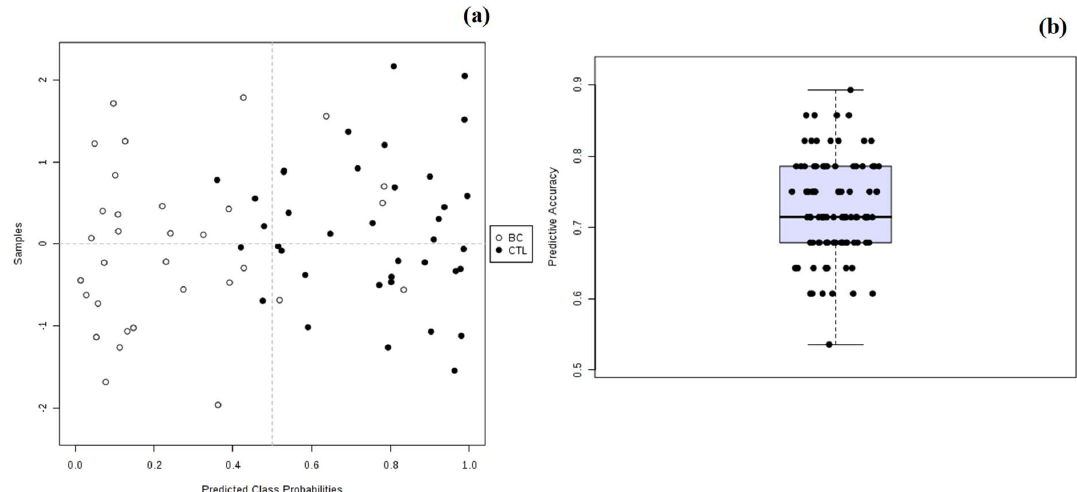
Figure 6. ( a ) Plot of the predicted class probabilities for all samples using the OPLS-DA biomarker model based on AUC and ( b ) box plot of the predictive accuracy (with an average of 0.910) of the biomarker model based on 100 cross validations.